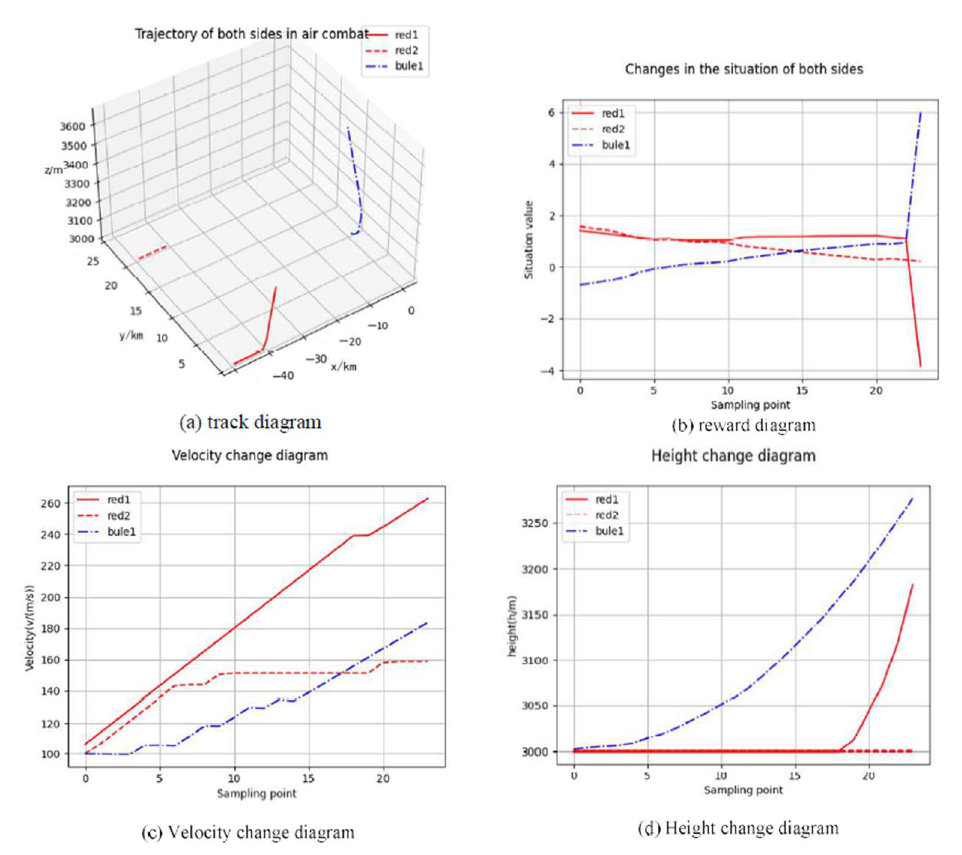
Figure 8. Simulation 2 of the blue UCAV hitting red 1.